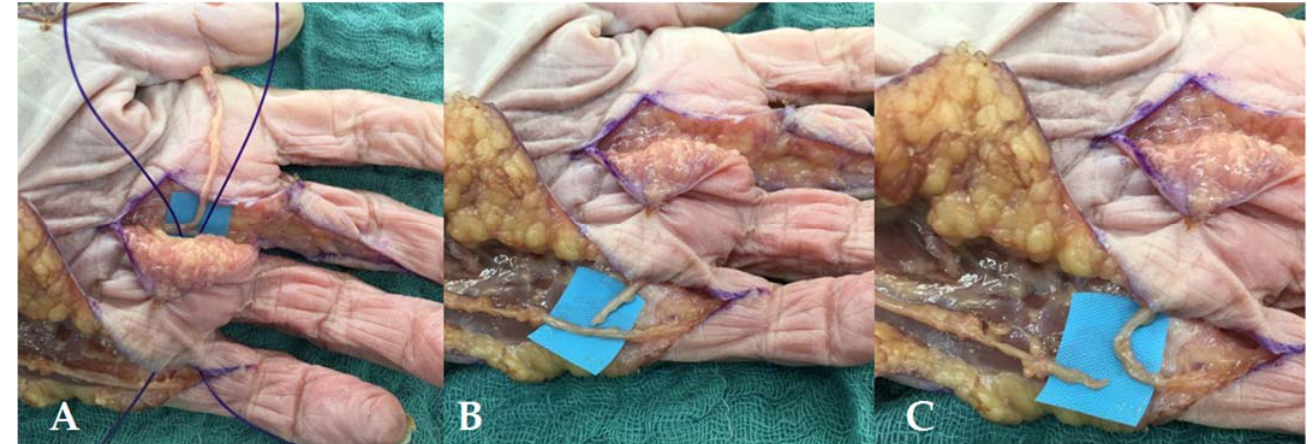
Figure 8. ( A ) Retrieving the ulnar branch of the third median digital nerve. We used a PDS loop to retrieve the donor nerve through a subcutaneous channel. ( B ) Isolation of the donor nerve. We exposed the level of transection of the digital nerve of the small finger. ( C ) End-to-end (ETE) suture on the digital branch of the small finger. The digital branch of the small finger was transected proximally and an ETE suture was performed at the distal crease level of the palm.